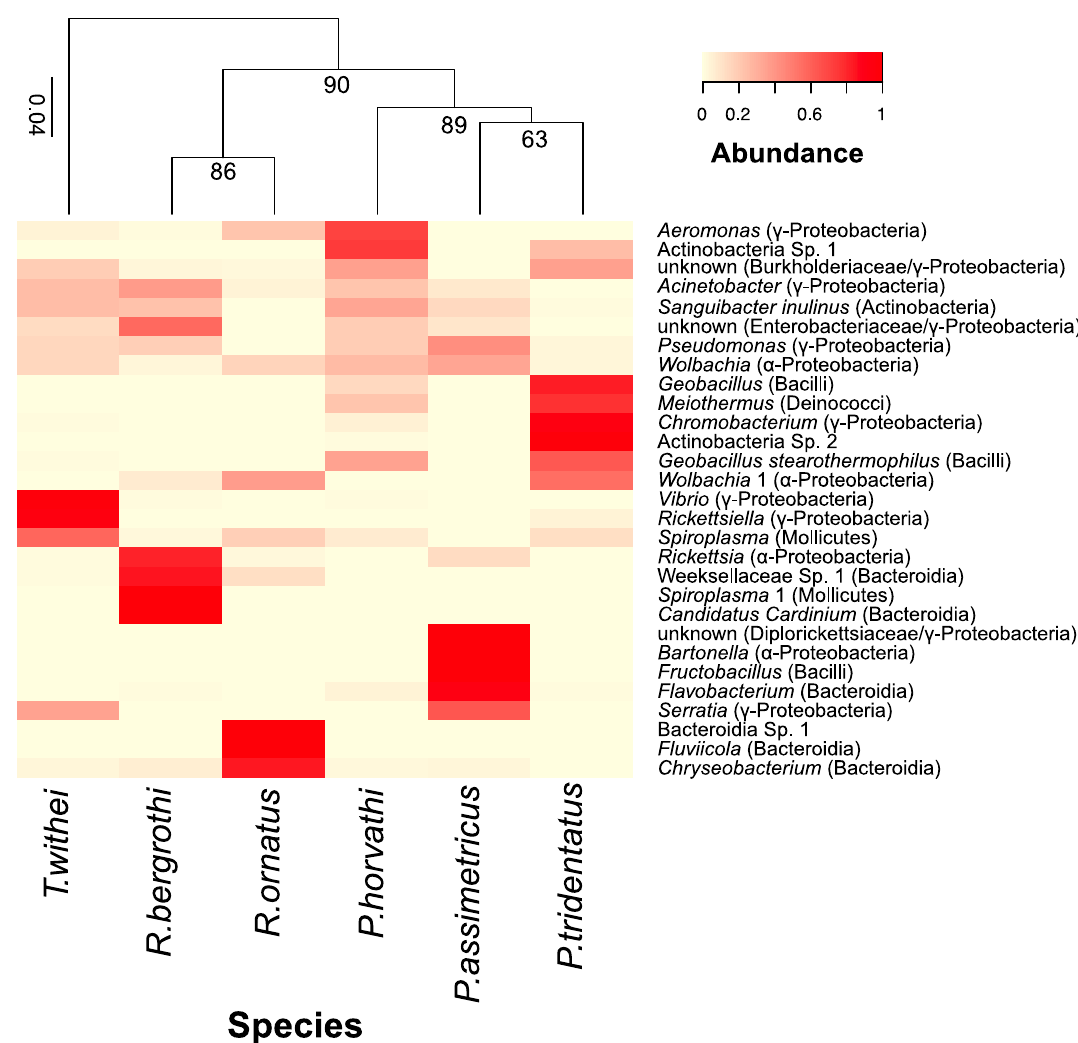
Figure 5. Amplicon sequence variants (ASVs) of dominant bacterial taxa associated with the water striders. Only bacteria with a relative abundance of > 0.5% were included in the phylogeny analysis.